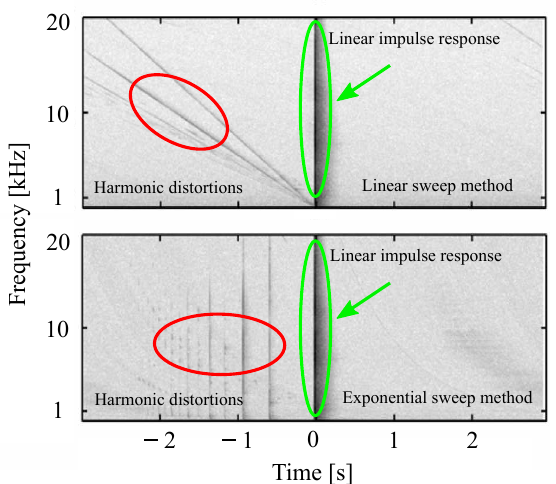
Figure 6. An example of measured system impulse responses (time-frequency representation) by using linear (upper panel) and exponential (bottom panel) sweeps as excitation signals. The bold and thin curves represent linear and harmonic responses, respectively (adapted from Figure 2 in